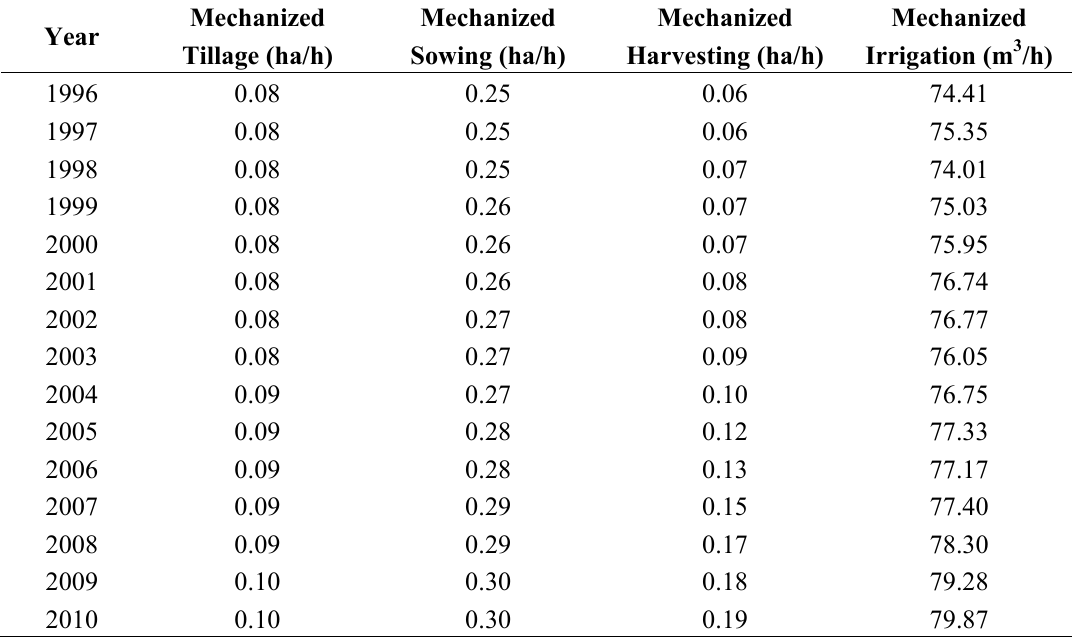
Table 3. Unit productivity of the four